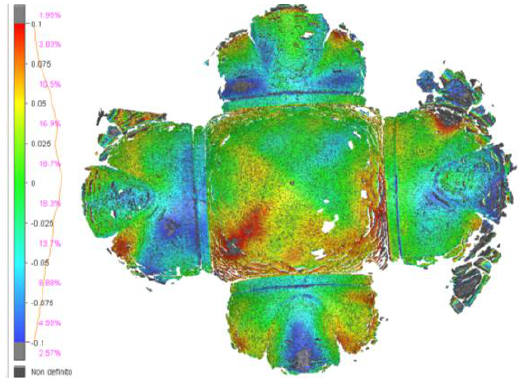
Figure 10 - Map of differences between the model from LIDAR data and the model produced by PhotoScan. 3D Reshaper processing.